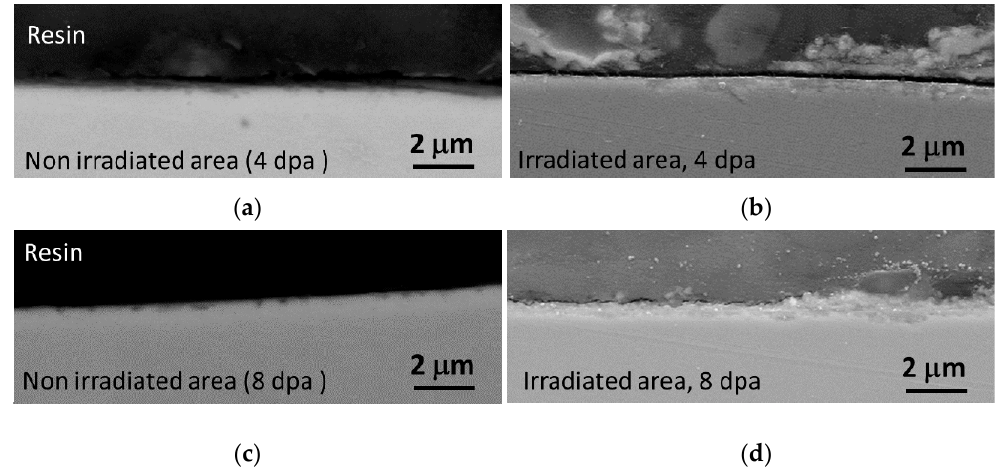
Figure 4. Cross-sectional SEM images after conducting corrosion tests for the irradiated 316L specimens. Upper and lower images denote: ( a , c ) nonirradiated area and ( b , d ) irradiated area of specimens irradiated at 4 and 8 dpa, respectively. The oxygen concentration was in the order of 10 − 9 wt.% in LBE. The images ( a , c ) and ( b , d ) were observed by AsB and SE detectors respectively, for convenience.